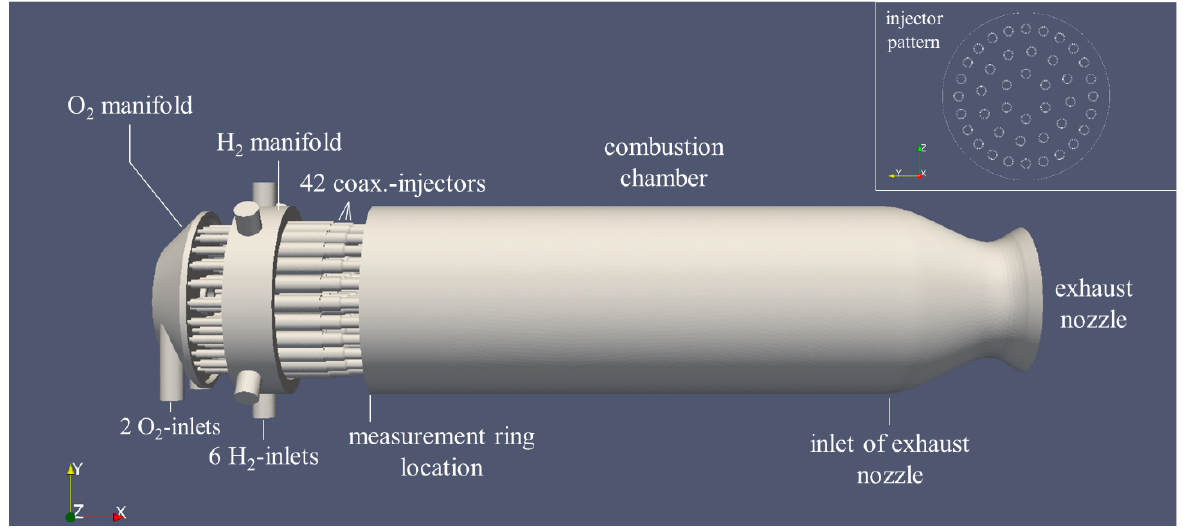
Figure 1. Geometry and components of the DLR-BKD combustor, with the arrangement of the injectors shown in the upper right corner. Table 1. Propellant supply conditions and theoretical estimate values.